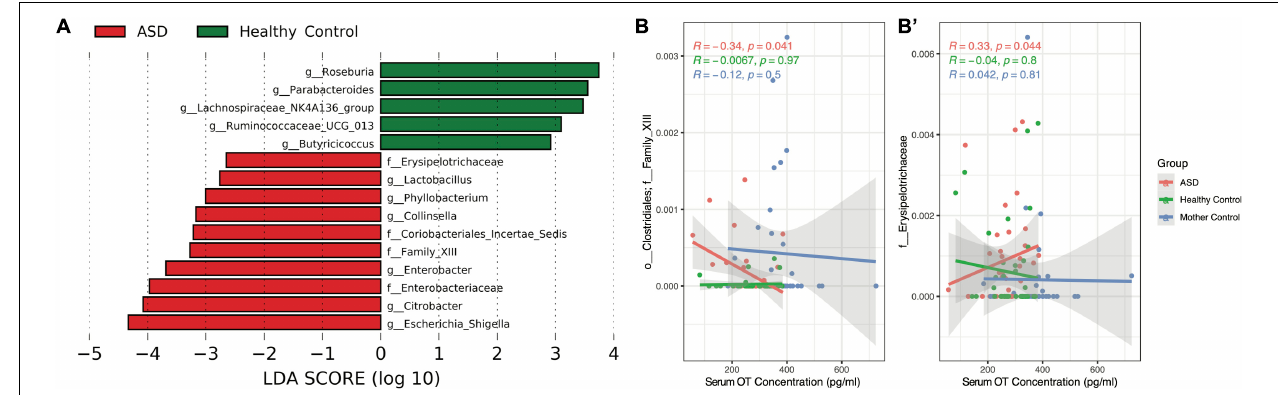
FIGURE 2 | Differentially abundant microbiota between ASD and HC group individuals and associated correlations with serum oxytocin concentration. (A) LDA effect size (LEfSe) analysis was conducted to assess for differentially abundant taxa using the one-against-all strategy for multi-class analysis with α = 0.05 for the factorial Kruskal–Wallis test between groups and a threshold of 2.0 for the logarithmic LDA score for discriminative features. (B,B (cid:48) ) Spearman’s rank correlation of serum oxytocin concentration against significant differentially abundant taxa. Significant correlations using α = 0.05 are